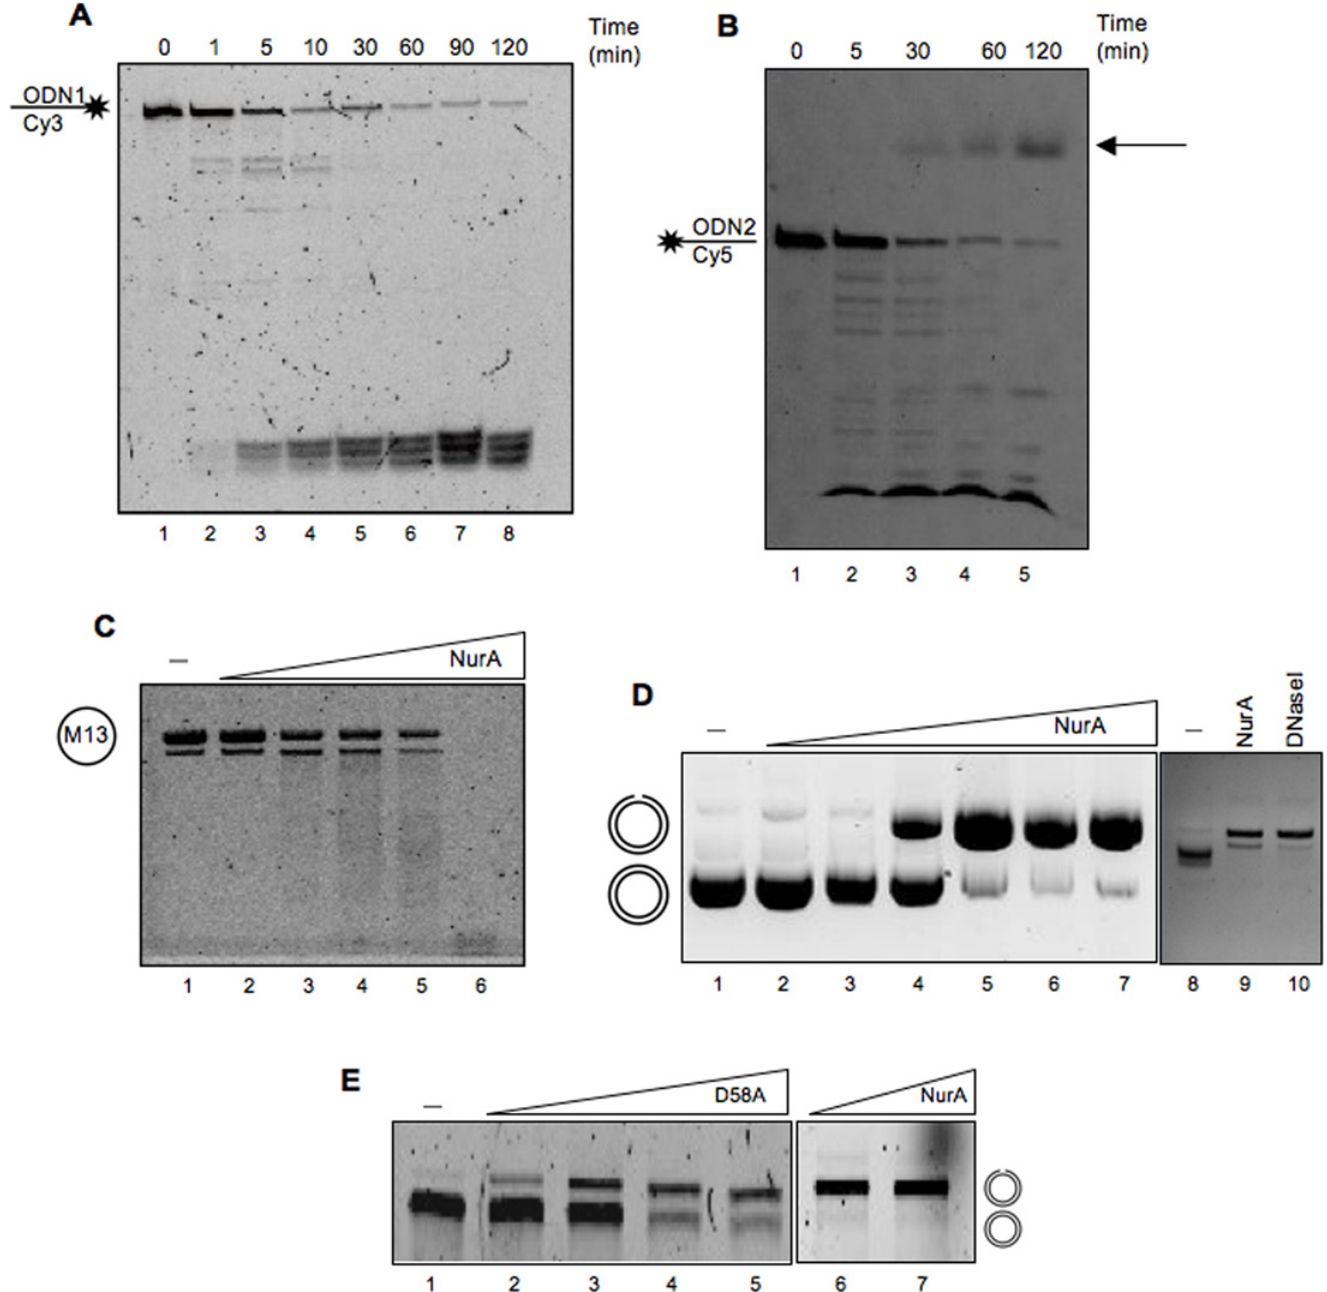
Fig 3. Nuclease activity of NurA on different DNA substrates. NurA nuclease activity on linear single-stranded DNA labeled at its 3 ’ -end (A) or 5 ’ -end (B). A time course analysis has been conducted to analyze NurA nuclease activity on these substrates in order to visualize the whole different products coming out from its activity. (C) NurA endonuclease activity on a single-stranded DNA (M13). Increasing concentrations of NurA (from 0.6 to 12.5 pmoles) have been used to test its endonuclease activity on a circular single-stranded DNA (lanes 2 – 6). Lane 1 is a control in which M13 has been incubated with no protein. (D) Analysis of NurA endonuclease activity on a circular double-stranded DNA. Increasing amounts of NurA (from 0.1 to 7.5 pmoles) have been analyzed for its endonuclease activity (lanes 2 – 7). A control lane with no protein has been run (lane 1). Control experiments were conducted to compare the activity of NurA (lane 9) and 0,1 nmol of commercial DNaseI (lane 10). A control lane with no protein has been run (lane 7). (E) Increasing amounts (1, 2.5, 5 and 10 pmoles) of NurA D58A were analyzed for their nuclease activity (lanes 2 – 5), on circular double-stranded DNA, lane 1 refers to control in which the only substrate has been loaded, lanes 6 and 7 refer to NurA wt alone as positive control (5 and 10 pmoles).